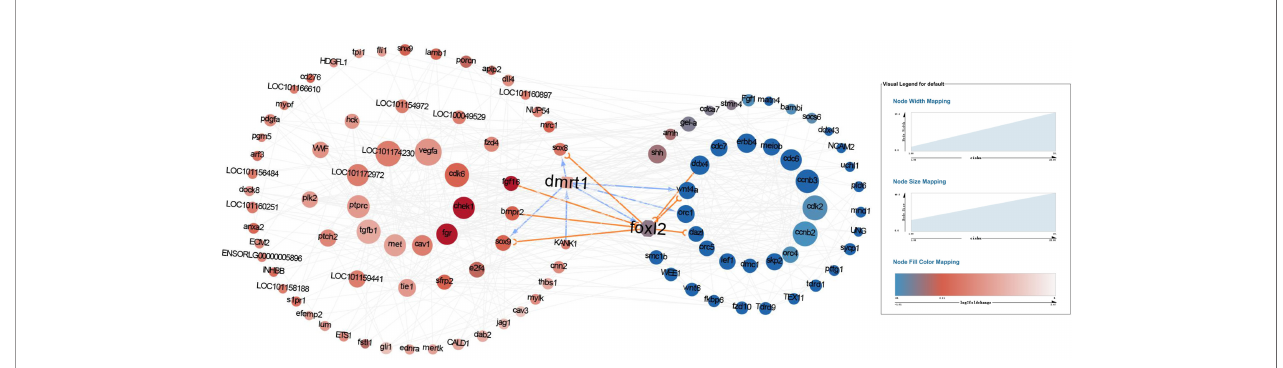
FIGURE 5 | The protein-protein interaction networks with the differential genes detected from pathway analysis. The red and blue cycles represent the upregulated proteins in males and females, respectively. The darker the dot, the more signi fi cantly upregulated of the protein. And the bigger the dot, the more interactions.